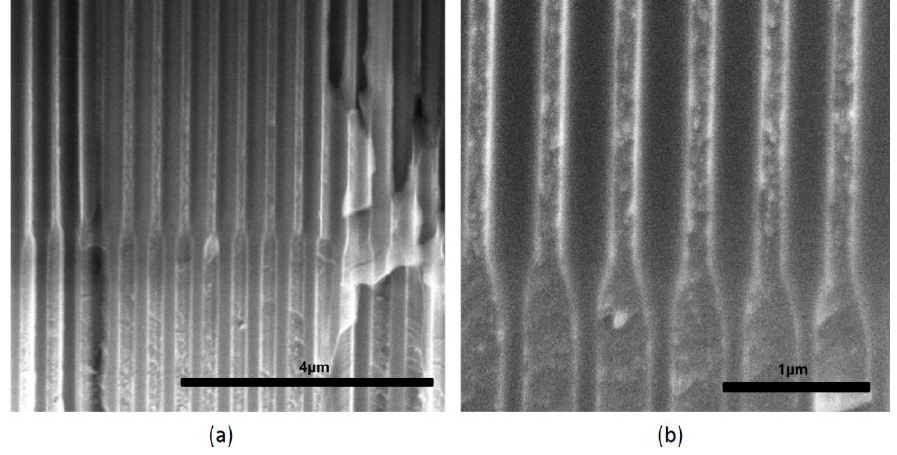
Figure 2. Cross-section Environmental Scanning Electron Microscopy (ESEM) images of a two layered normal funnel structure (NF2) illustrating ( a ) the uniform pore growth, and ( b ) the pore transition.